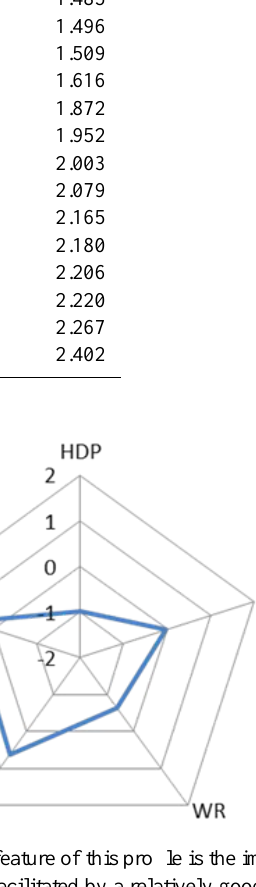
Profile 4: essential external support (Fig. 8, Table